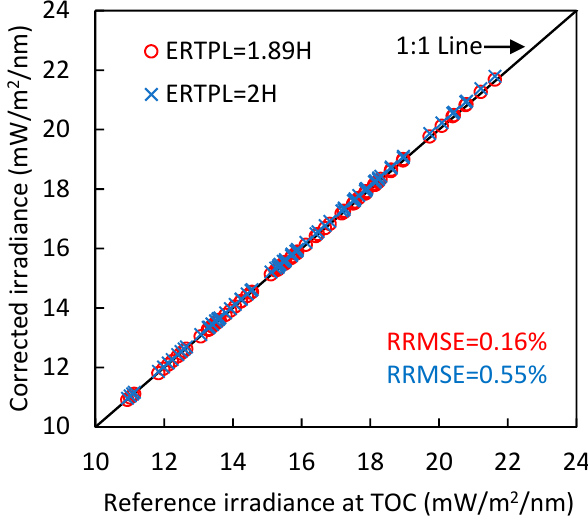
Figure 6. Comparison of irradiance at 761.1 nm corrected using the ERTPL of 1.89H or 2H and the simulated reference irradiance at top of canopy.